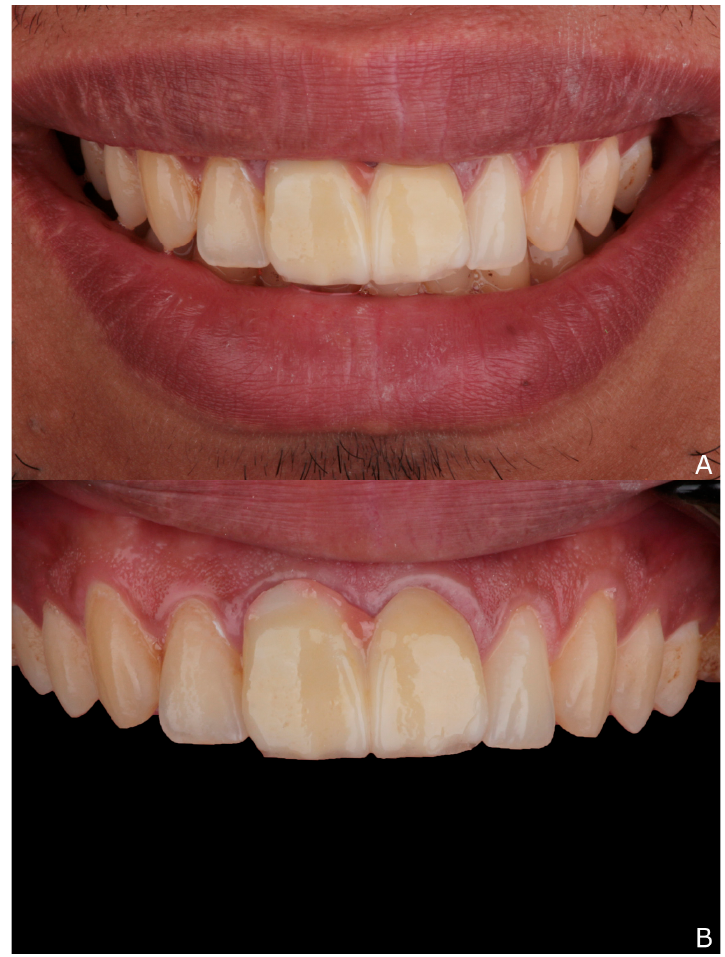
Figure 1. ( A , B ), Initial situation of two maxillary central incisors with old connected metal ceramic crowns.